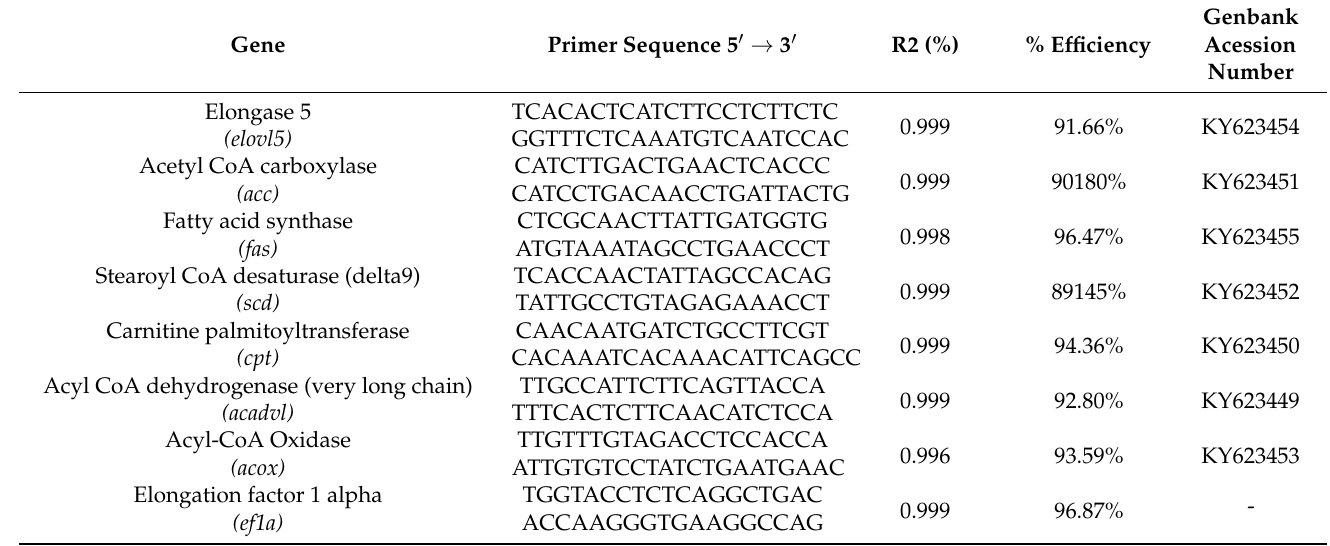
Table 3. Nucleotide sequence of primers used for real-time quantitative (qPCR) amplification.